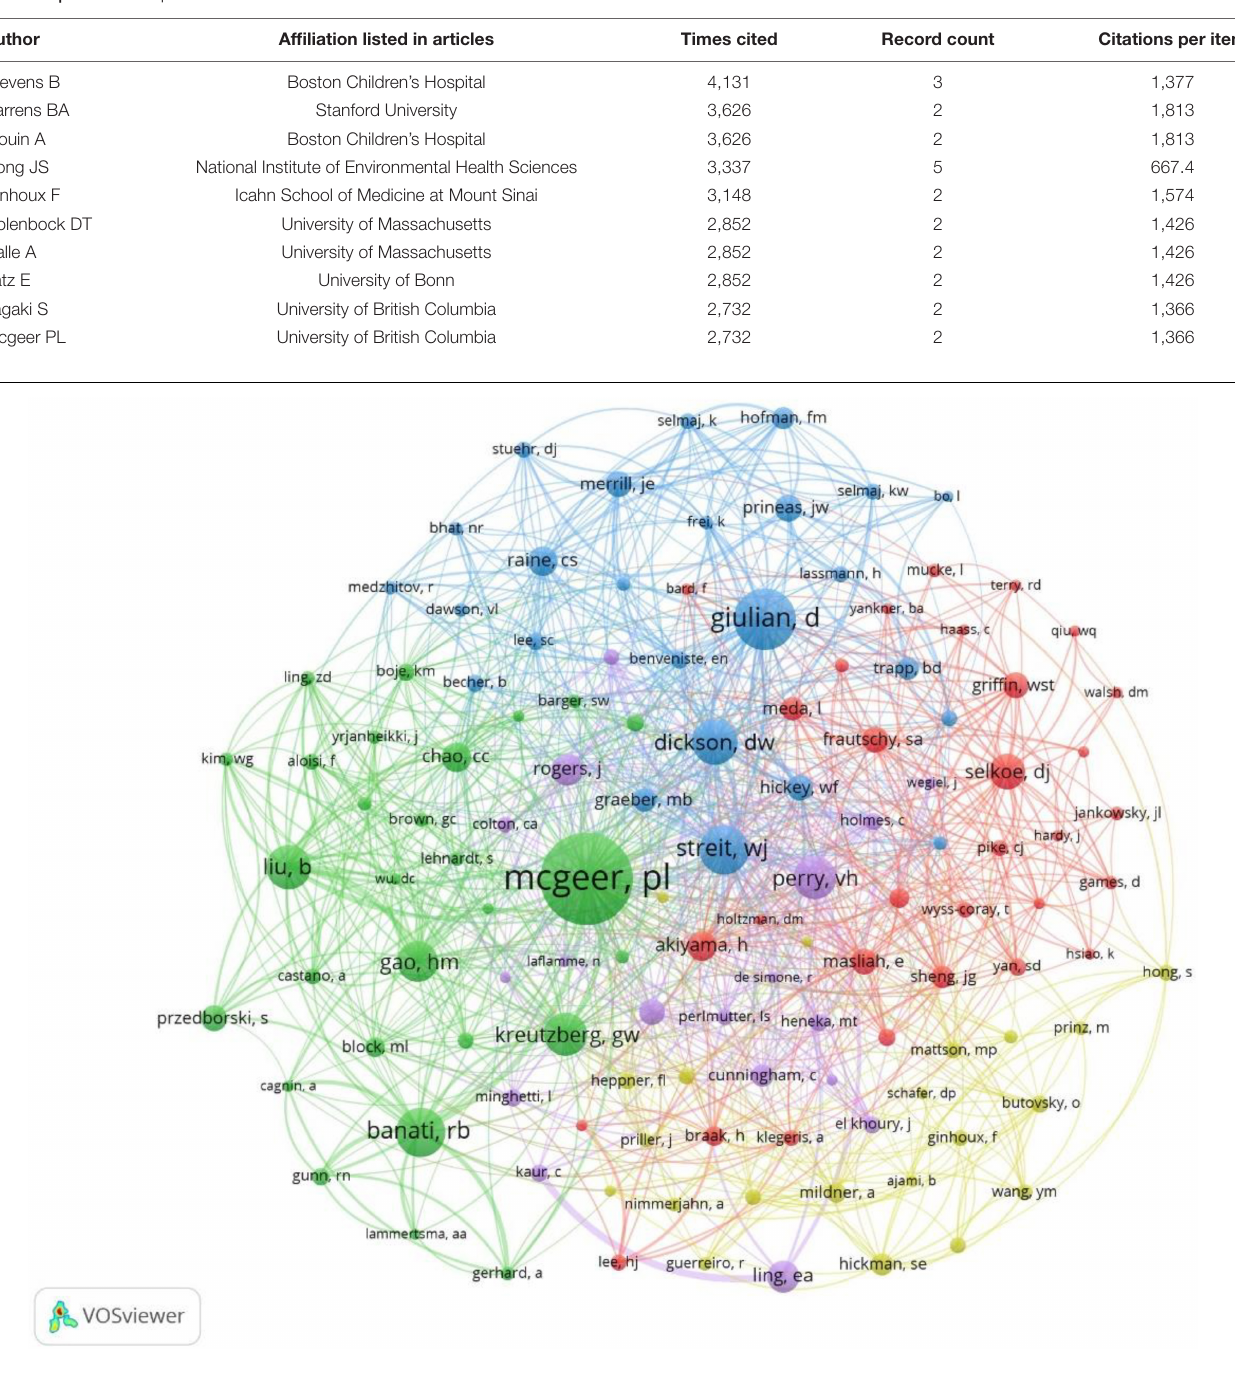
FIGURE 7 | Co-citation analysis of most frequently cited authors in the reference lists, weighed by citations, visualized map.